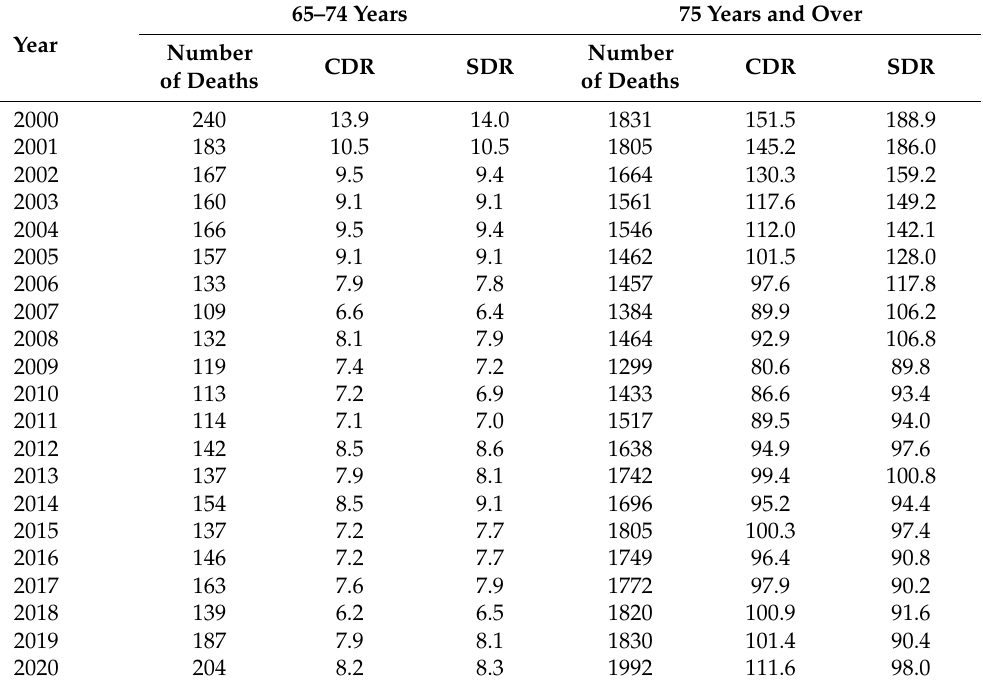
Table 3. Number of deaths, crude death rates (CDRs) and standardized death rates (SDRs) due to falls in women aged 65–74 years and 75 years and over in Poland in